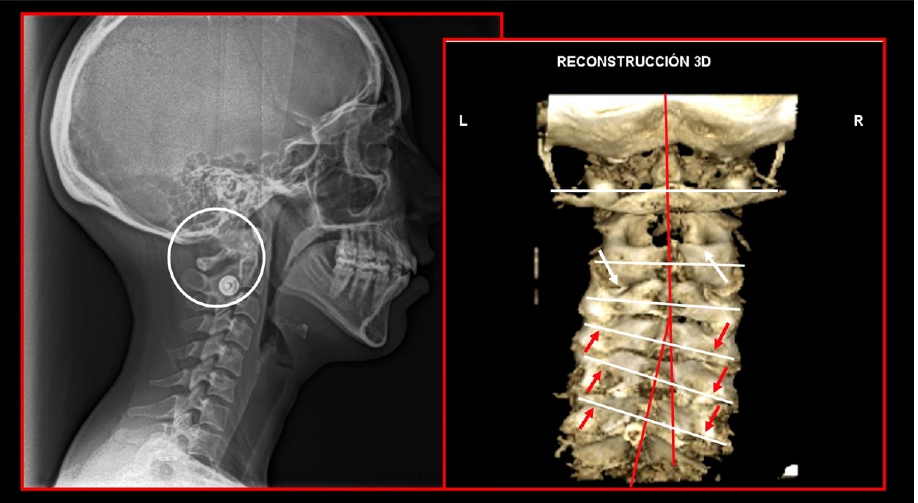
Figure 16. Decreased functional space between posterior arch of the atlas and spinous process of C2. Static atlas on the axis . Loss of cervical lordosis. Scoliosis. Left: lateral cephalometric radiography. Right: three-dimensional computed tomography reconstruction.